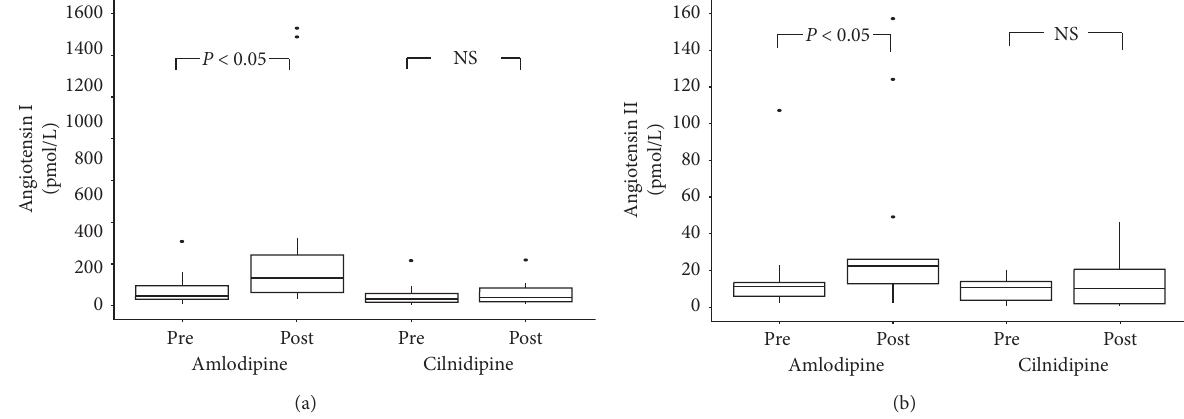
Figure 5: Changes in the plasma Ang I (a) and Ang II (b) levels before and after the treatment. After 6 months of treatment, significant increases in both plasma Ang I and Ang II levels were observed in the amlodipine group but not in the cilnidipine group. Ang I, angiotensin I; Ang II, angiotensin II.